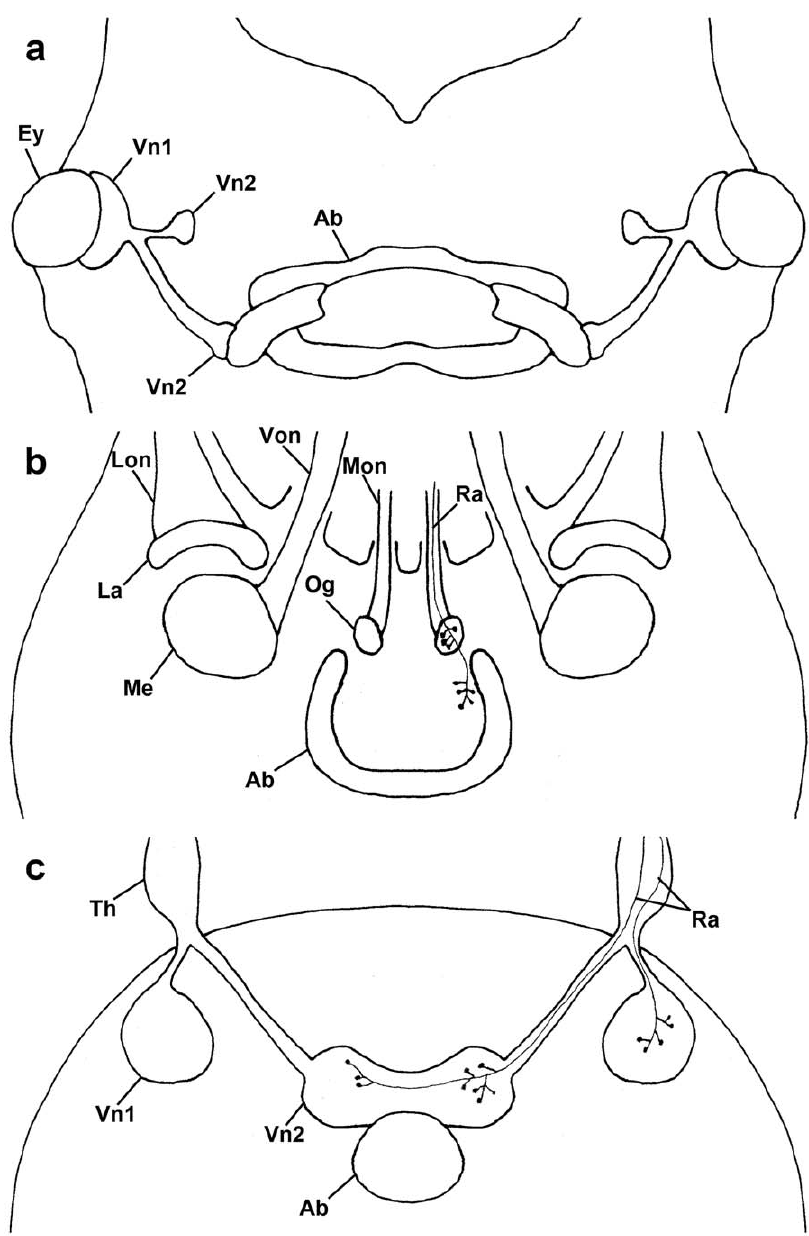
Figure 4. Comparison of visual systems of (a) Onychophora ( Euperipatoidesrowelli ), (b) Xiphosura ( Limuluspolyphemus ), and (c) Pycnogonida ( Achelia spp., Endeisspinosa ). Ab, arcuate body; Ey, eye; La, lamina; Lon, lateral optic nerve; Me, medulla; Mon, median optic nerve; Og, ocellar ganglion; Ra, retinula axon; Th, thickening; Von, ventral optic nerve; Vn, visual neuropil. a , Visual pathways from the eyes are shown, with first and second optic neuropils indicated. After Strausfeld et al. [ 27 ]. b , Terminals of median rudimentary photoreceptor have some branches in ocellar ganglion, then continue and terminate near central body. After Calman et al. [16]. c , Summary of the situation found in the three pycnogonid species studied